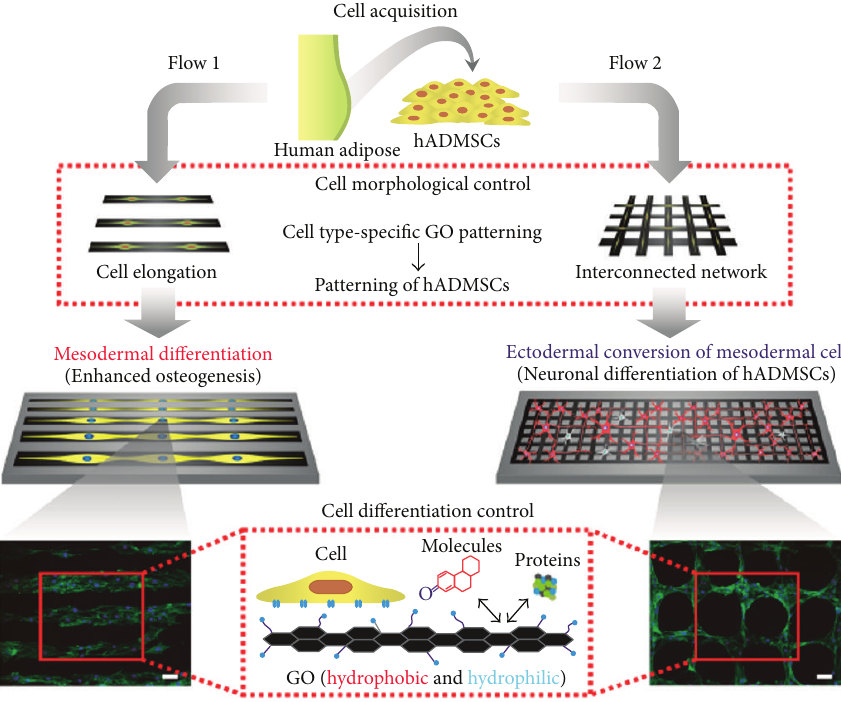
Figure 4: Graphene pattern controlled ASCs differentiation. The schematic illustrates the steps taken to modulate the morphology of ASCs using graphene oxide patterns, which further guide the differentiation of ASCs. Fluorescent images are F-actin stained ASCs. (Scale bar = 100 𝜇 m.) Flow 1: the line pattern enhances the osteogenesis of ASCs. Flow 2: the mesh pattern enhances the neurogenesis of ASCs (adopted from